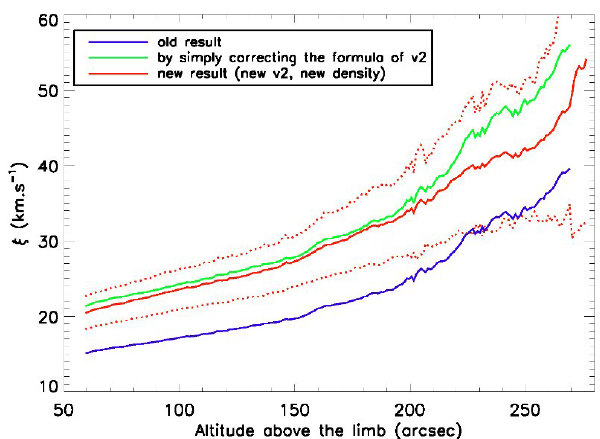
Fig. 3. Non-thermal velocity with increasing altitude above the po- lar coronal hole. In blue, the value derived in Paper I. In green, when the factor 2 is included in the formula of v 2 (see text). In red, the new result when both the formula is corrected and the new de- rived density is taken into account. The red dotted lines denote the error bars for the new value of ξ